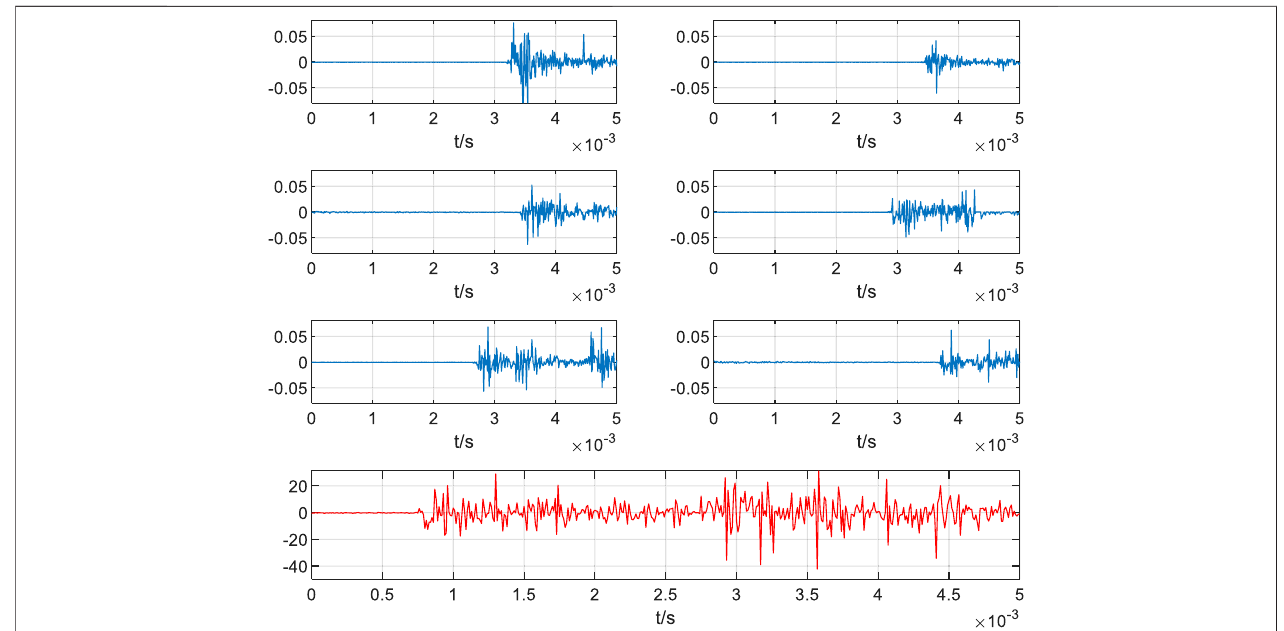
FIGURE 11 | Recording results of ultrasonic localization experiment of Field experiment transformer.